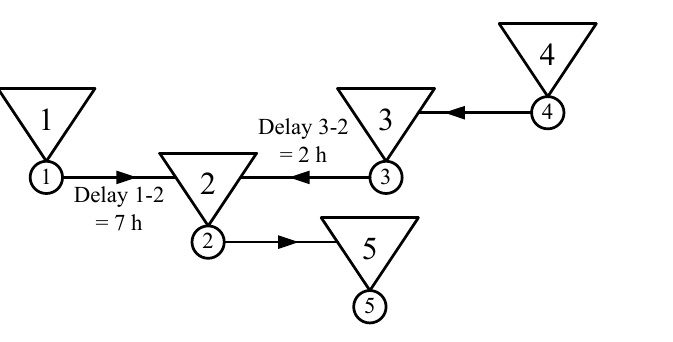
Figure 1. Model of the Cetina cascade hydro